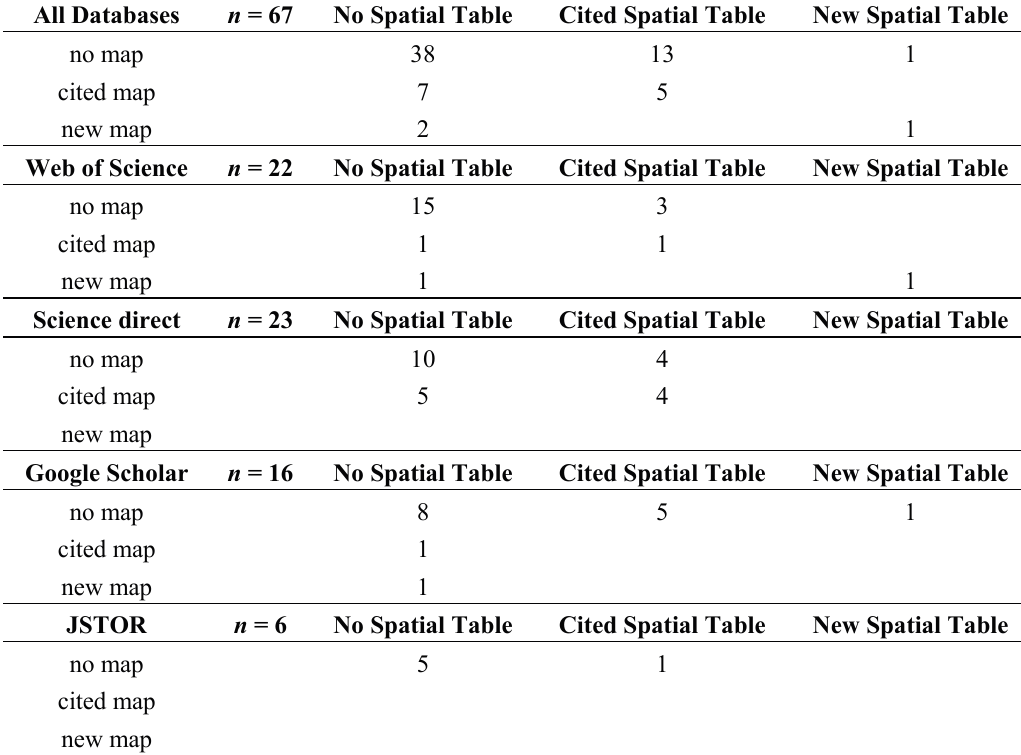
Table 2. Proportions of publications with or without, with cited or created spatial maps and tables.